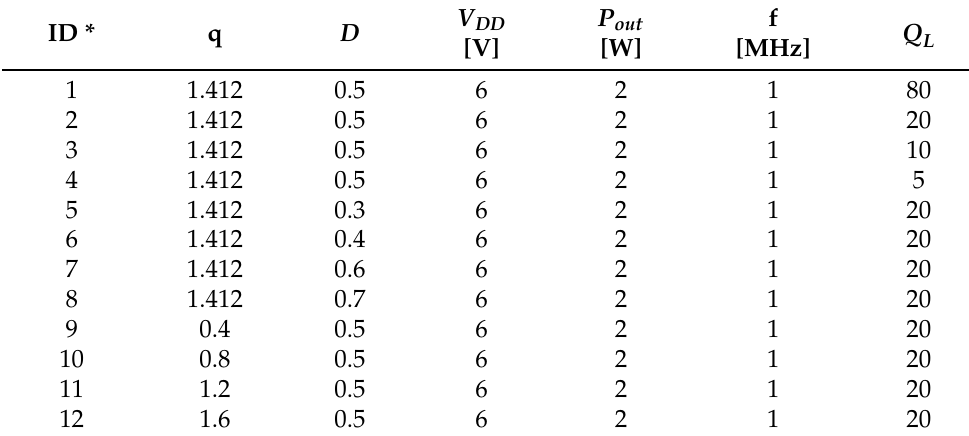
Table 3. Circuit specifications and model parameters.